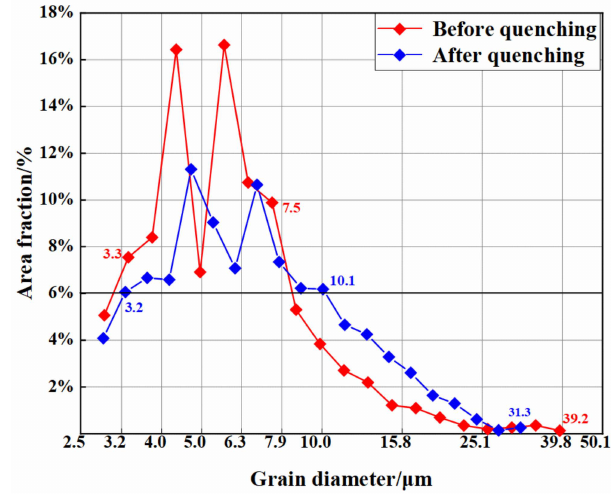
Figure 17. Statistics of the grain